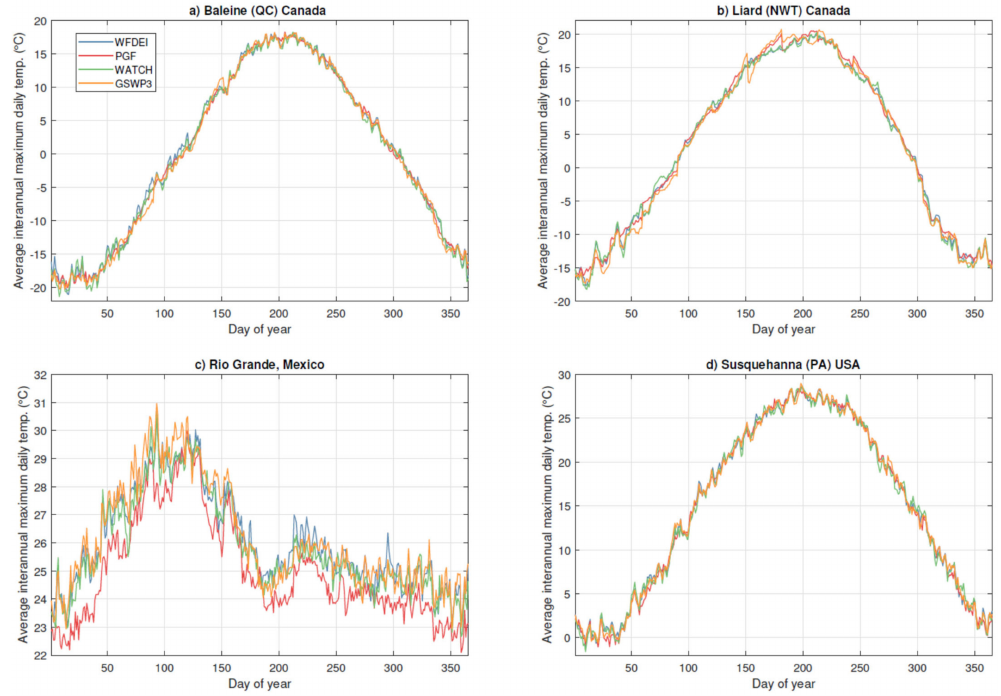
Figure 7. Average interannual maximum daily temperature from the four global meteorological datasets (WFDEI, Princeton PGMFD, WATCH, and GSWP3) over the ( a ) Baleine, ( b ) Liard, ( c ) Rio Grande, and ( d ) Susquehanna river basins over the 1971–2010